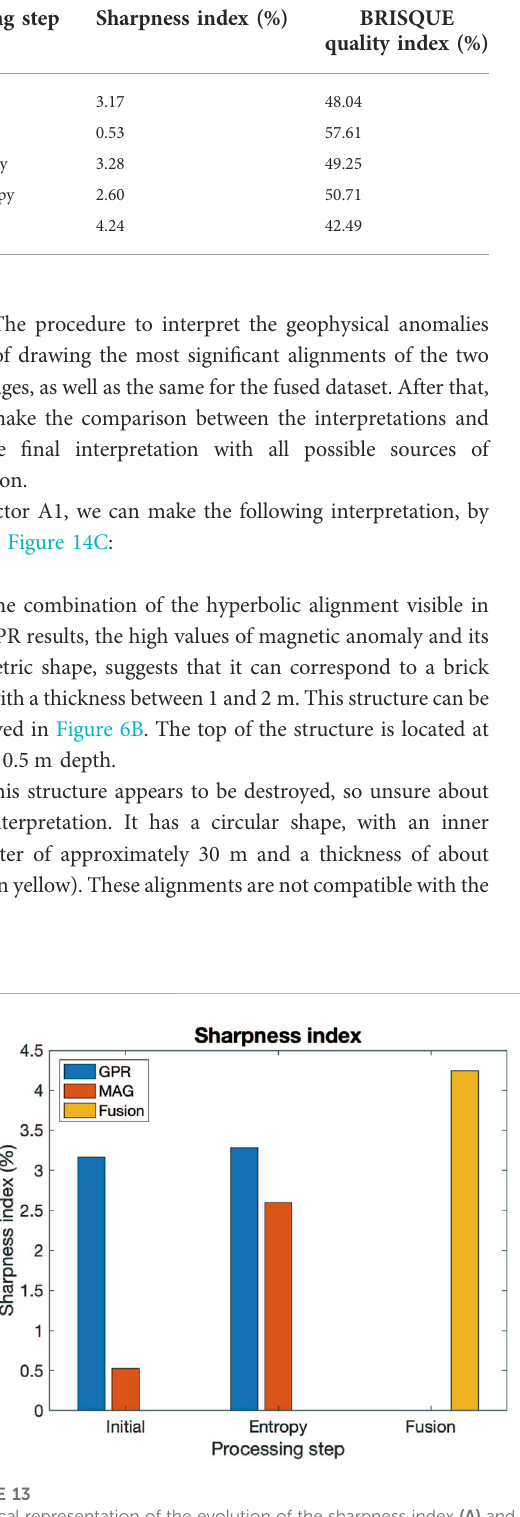
Frontiers in Earth